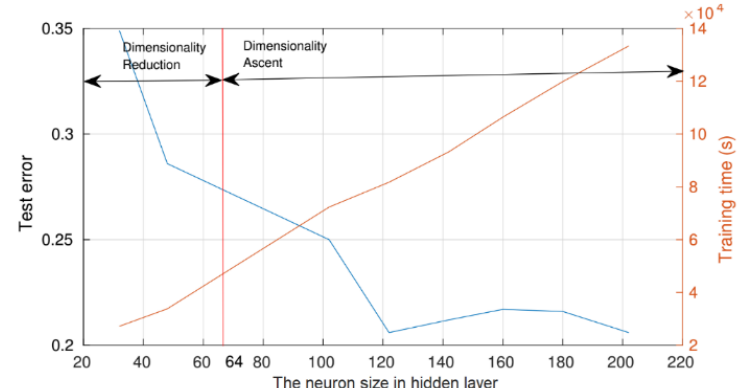
Figure 4. The relationship between the test error and error bars, training time, as well as training data proportion.